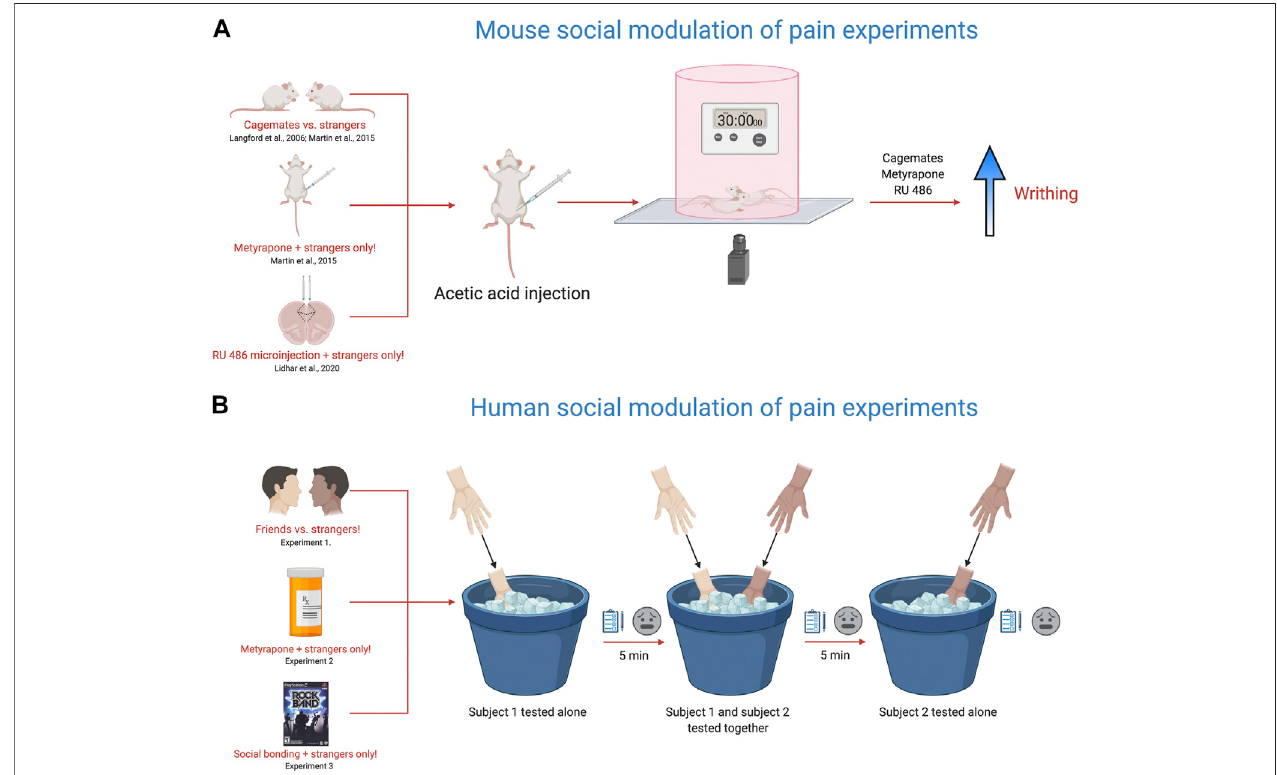
FIGURE 2 | Translational behavioral models to test the in fl uence of social context on pain responses. (A) . Using the acetic acid (0.9%) writhing test and manipulatingsocialpartner,drugpre-treatmentortargetingspeci fi cbrainareas,thenociceptiveresponsesofmicearealteredwithinthesocialenvironment.Placingtwo mice in a cylinder and injecting both mice with acetic acid (0.9%) enhances the nociceptive response of cagemates, but not strangers as originally reported in Langford et al., 2006. Further work with this model, showed that metyrapone, a glucocorticoid synthesis inhibitor recapitulated the cagemate effect in strangers, with metyrapone-injectedstrangermiceshowingincreasednociception(Martinetal.,2015).Inaddition,targetedinjectionsofRU-486,aglucocorticoidreceptorblockeralso facilitated the nociceptive response of stranger mice (Lidhar et al., 2020). (B) . The cold pressor task was used to measure pain ratings in friends vs. strangers, strangers pre-treated with metyrapone and in strangers after engaging in a shared social experience (Martin et al., 2015). The experiment consists of three testing trials using the cold-pressor task. In the fi rst test trial, subject 1 is tested alone by placing their non-dominant hand in the cold pressor for 30 s and then rating the pain intensity and unpleasantness using a visual analog scale. In the second trial, the second subject is brought into the room and both subjects are tested together by placing their non- dominant hand in the cold pressor for 30 s and then rating the pain intensity and unpleasantness using a visual analog scale. For the third trial, the second subject is tested alone by placing their non-dominant hand in the cold pressor for 30 s and then rating the pain intensity and unpleasantness using a visual analog scale. During